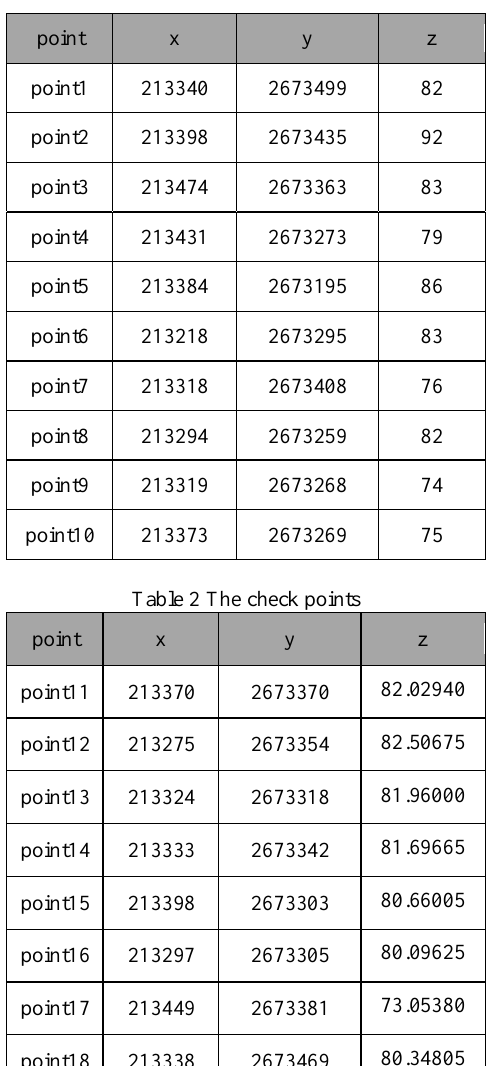
Figure 4 .(b) The check points Table 1. The ground control points